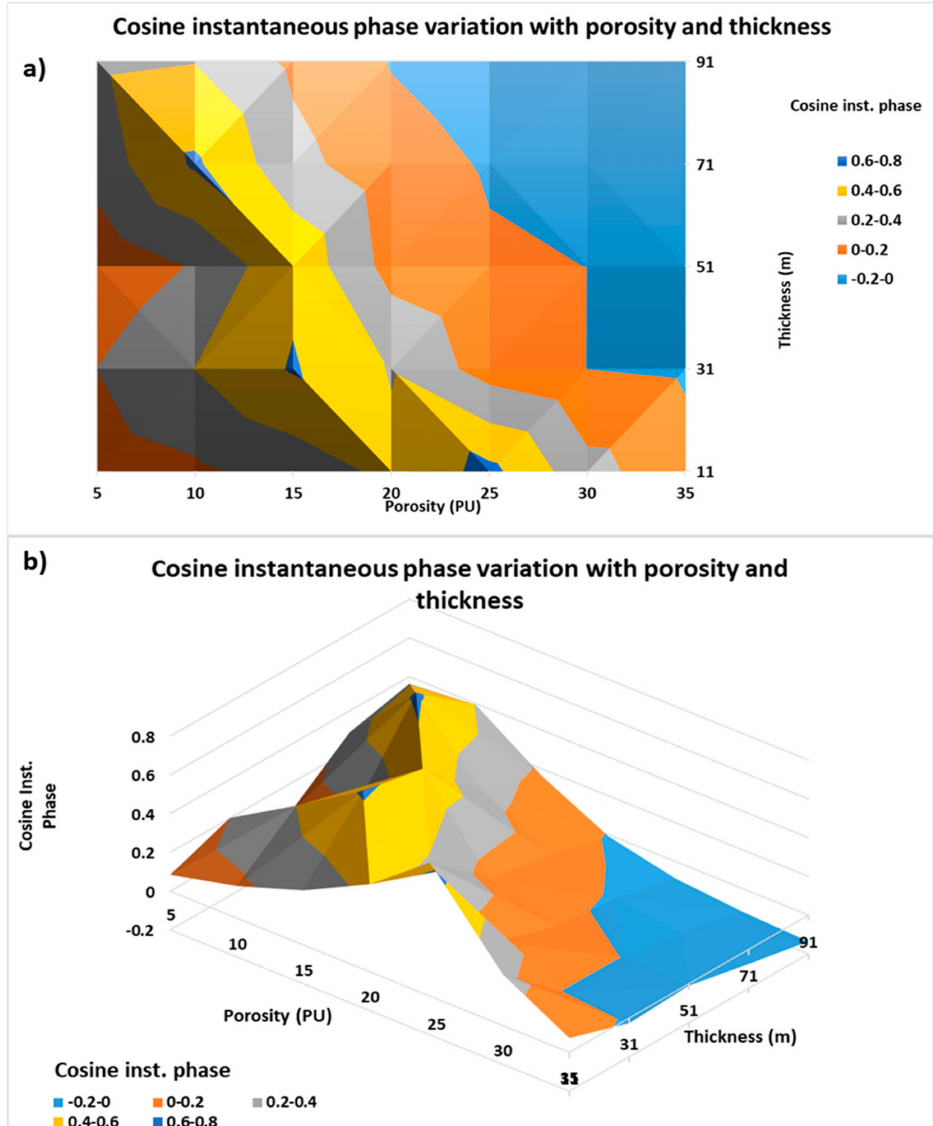
Figure 7. Cosine of the instantaneous phase variation at 700 ms for porosity versus thickness wedge models. ( a ) Crossplot view and ( b ) 3D